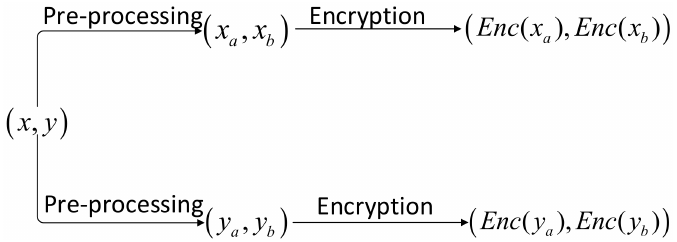
Figure 4. Encryption process after processing data using the integer-pair encoding